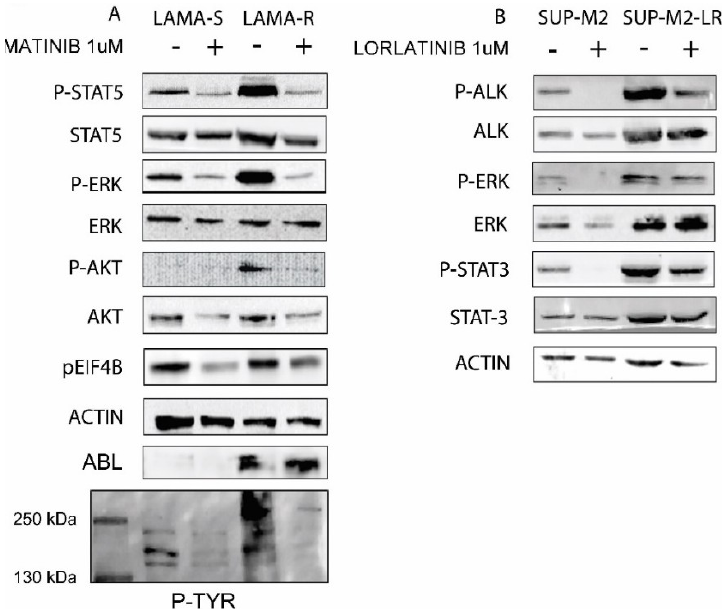
Figure 2. Drug withdrawal causes an oncogene driven signaling overflow. ( A ) LAMA-S and LAMA-R or ( B ) SUP-M2 and SUP-M2-LR cell lines were kept in the presence or in the absence of IMATINIB 1 µ M or LORLATINIB 1 µ M respectively for 4 h. Then cells were harvested, washed, and lysed. Western blot was performed with the indicated antibodies. + and − indicate the presence or the absence of the drug.